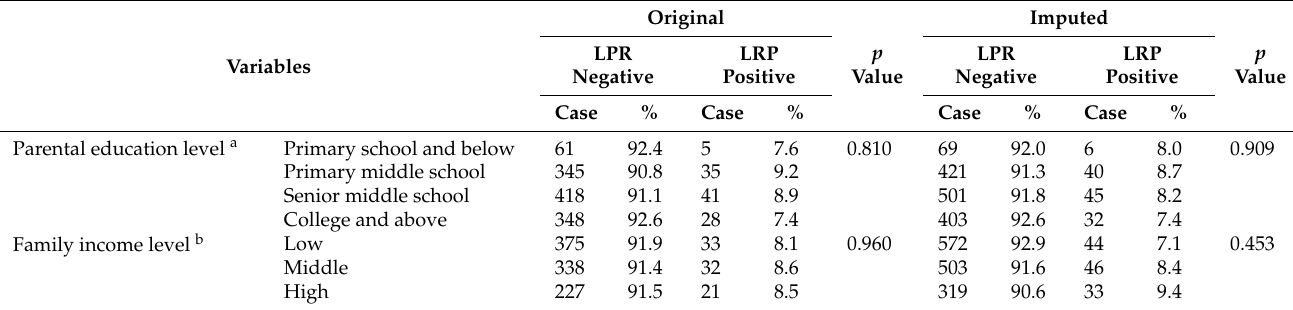
Table A5. Sensitivity analysis of the association between characteristics and RSI of